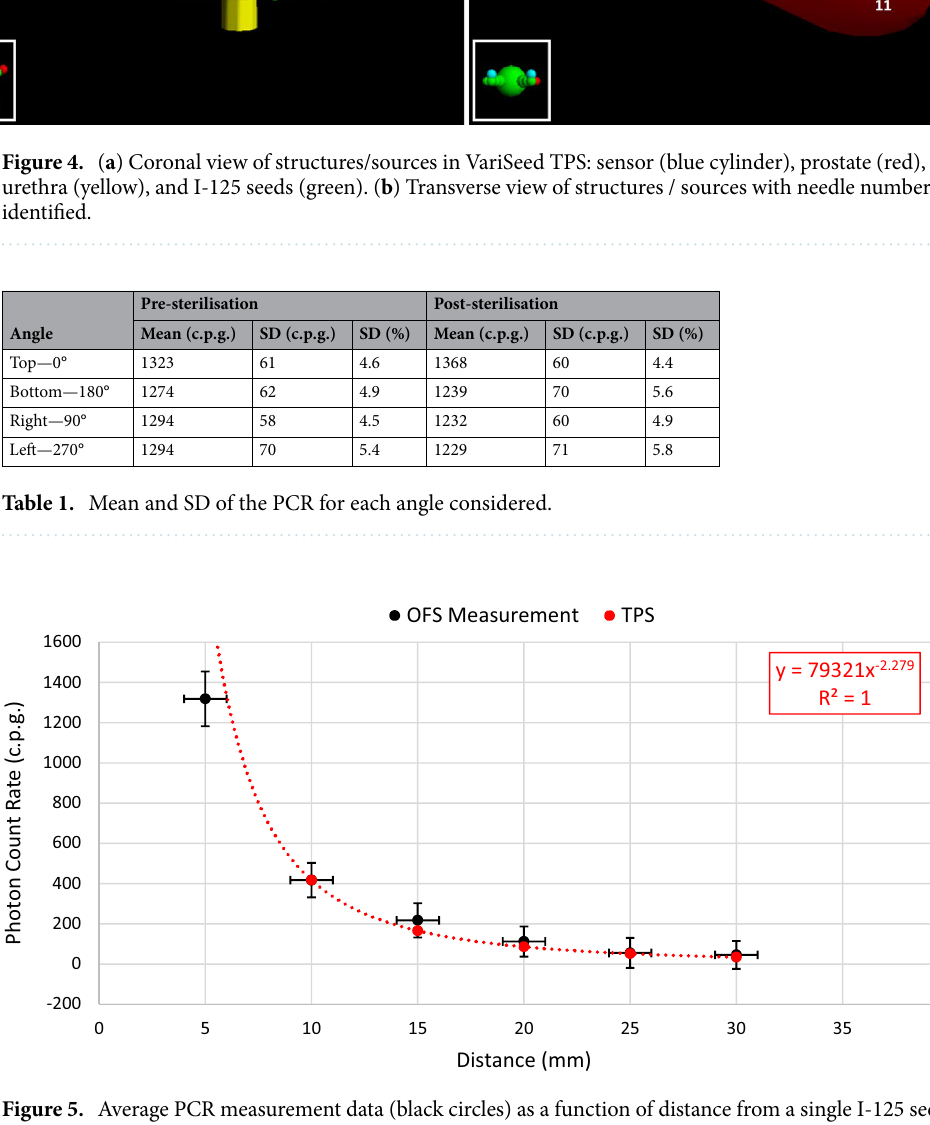
Figure 5. Average PCR measurement data (black circles) as a function of distance from a single I-125 seed obtained pre- and post-sterilisation. Theoretical data generated using the VariSeed TPS (red circles) are normalised to the PCR measurement value at 10 mm. The dashed red line represents a power trendline fit to the theoretical data, with the equation of the line shown in the top right corner of the graph in red